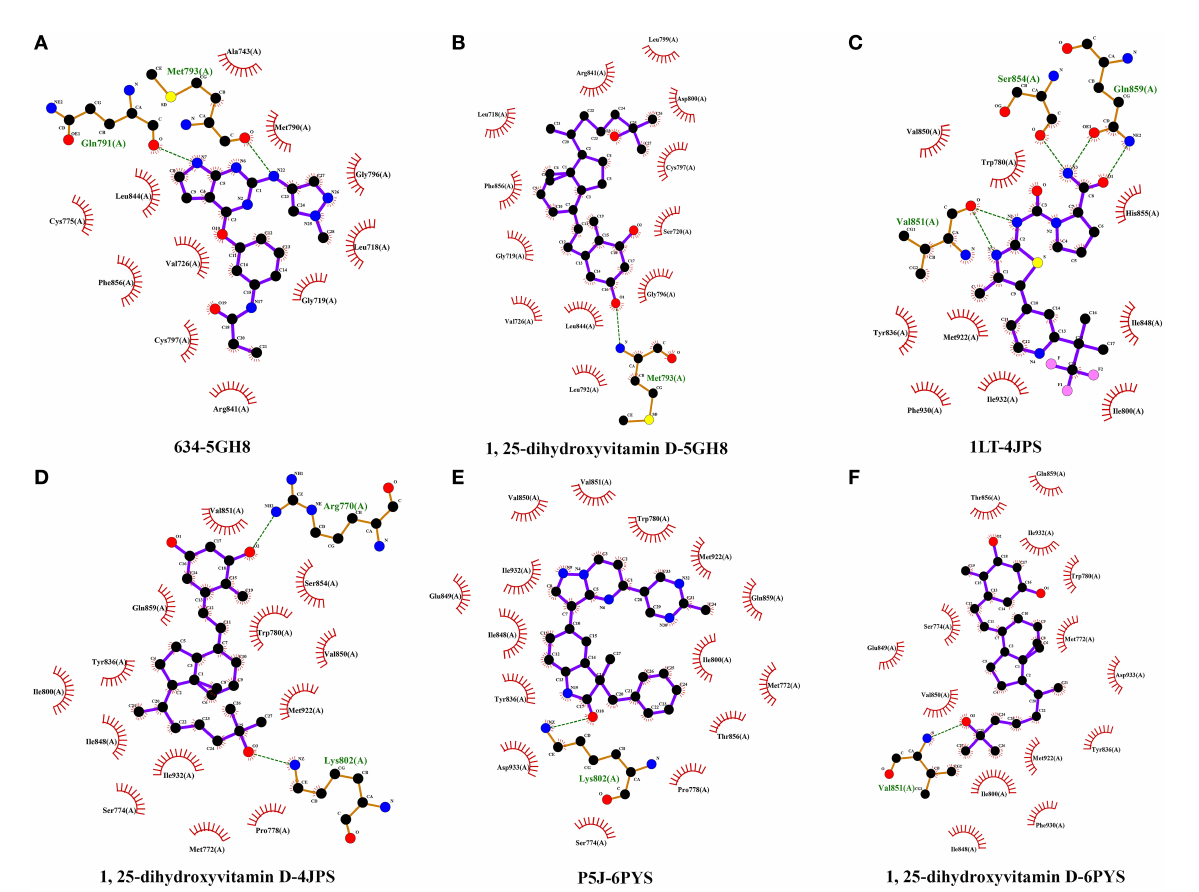
FIGURE9 The hydrophobic interactions of original ligands and 1,25-dihydroxyvitamin D with the target protein. Hydrophobic interactions are indicated by red opposite arcs. Hydrogen bonds are shown as green dashed lines. 634-5HG8 (A) , 1,25-dihydroxyvitamin D-5HG8 (B) , 1LT-4JPS (C) , 1,25-dihydroxyvitamin D-4JPS (D) , P5J-6PYS (E) , 1,25-dihydroxyvitamin D-6PYS (F)